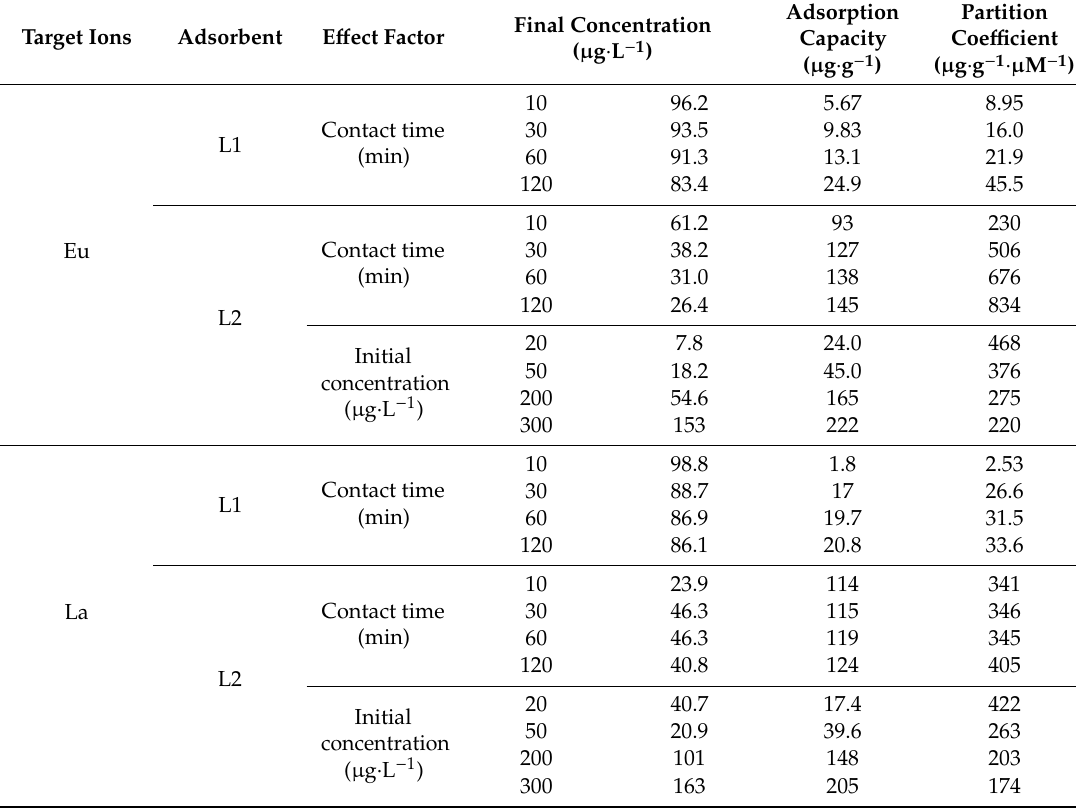
Table 2. Detailed experimental data of adsorption process under di ff erent e ff ect factor.